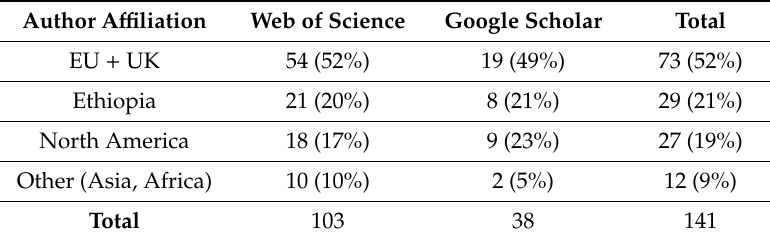
Table 1. Author a ffi liation of